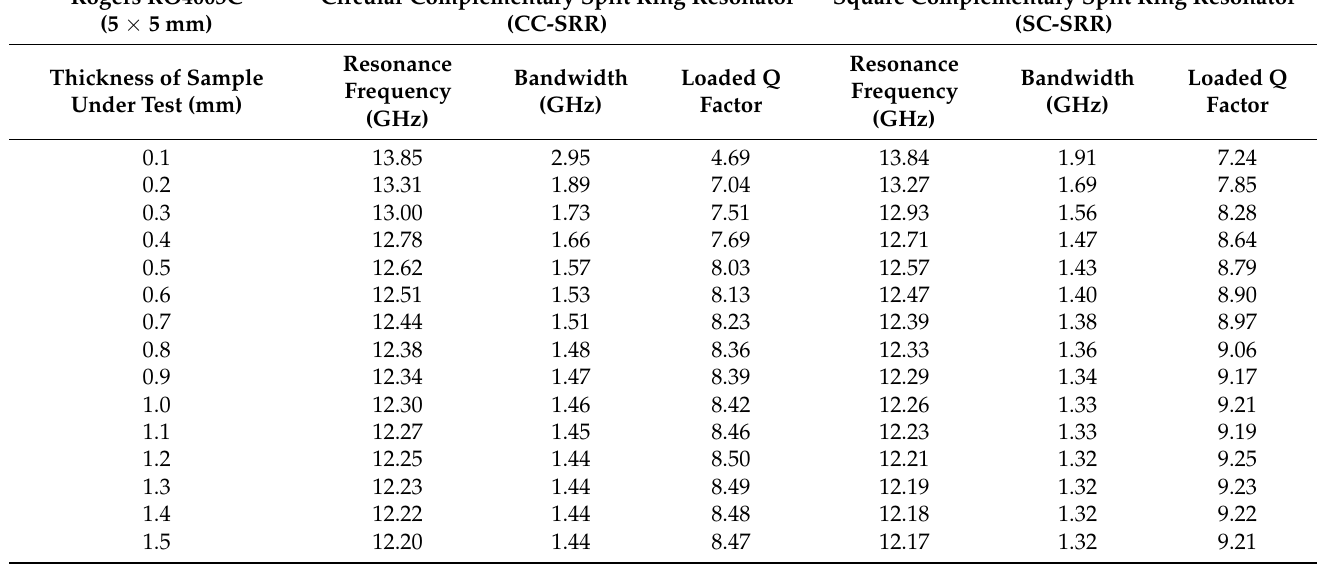
Figure 6. Effect of the SUT’s thickness on CC-SRR and SC-SRR sensors’ resonance frequency and notch depth. Table 1. The influence of the SUT’s thickness on the resonant frequency, bandwidth, and Loaded Q factor of the CC-SRR and SC-SRR sensors.